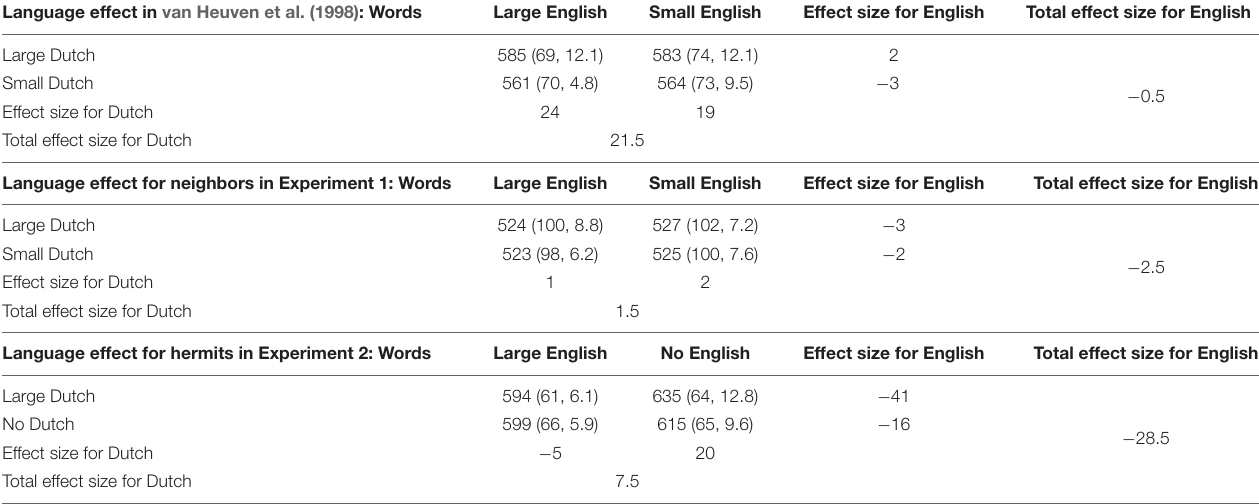
TABLE 2 | Mean RTs (in ms), standard deviations, error rates, and neighborhood effects for English word stimuli of English Lexical Decision in van Heuven et al. (1998, Experiment 4), our replication study (Experiment 1), and Experiment 2 with hermits. Language effect in van Heuven et al. (1998):